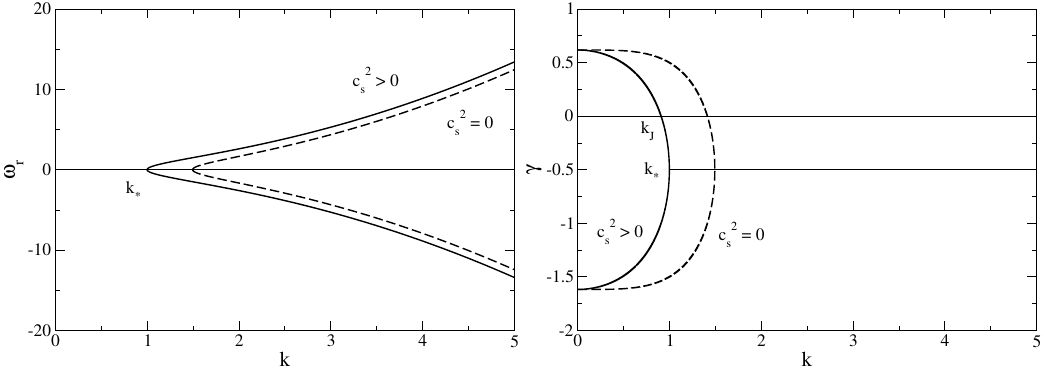
Figure 11. Dispersion relation for self-gravitating BECs in the general case when c 2 s ≥ 0. We have normalized the wavenumber by ( 4 π G ρ m 2 /¯ h 2 ) 1/4 , the pulsation and the friction by ( 4 π G ρ ) 1/2 , and the squared speed of sound by ( 4 π G ρ ¯ h 2 / m 2 ) 1/2 . This is equivalent to taking 4 π G = ρ = m = ¯ h = 1 in the dimensional equations. We have selected c 2 s = 1,0 and ξ =